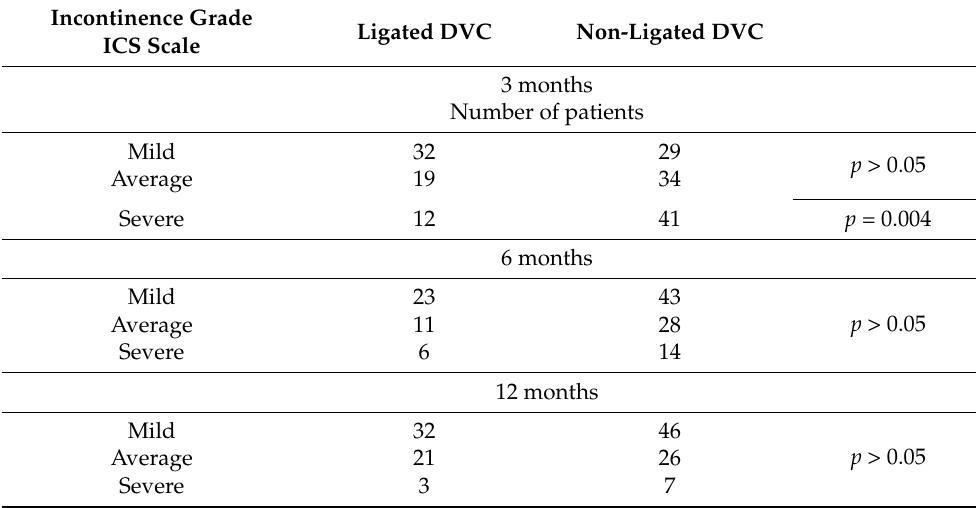
Table 6. Evaluation of incontinence grade in 12 months follow